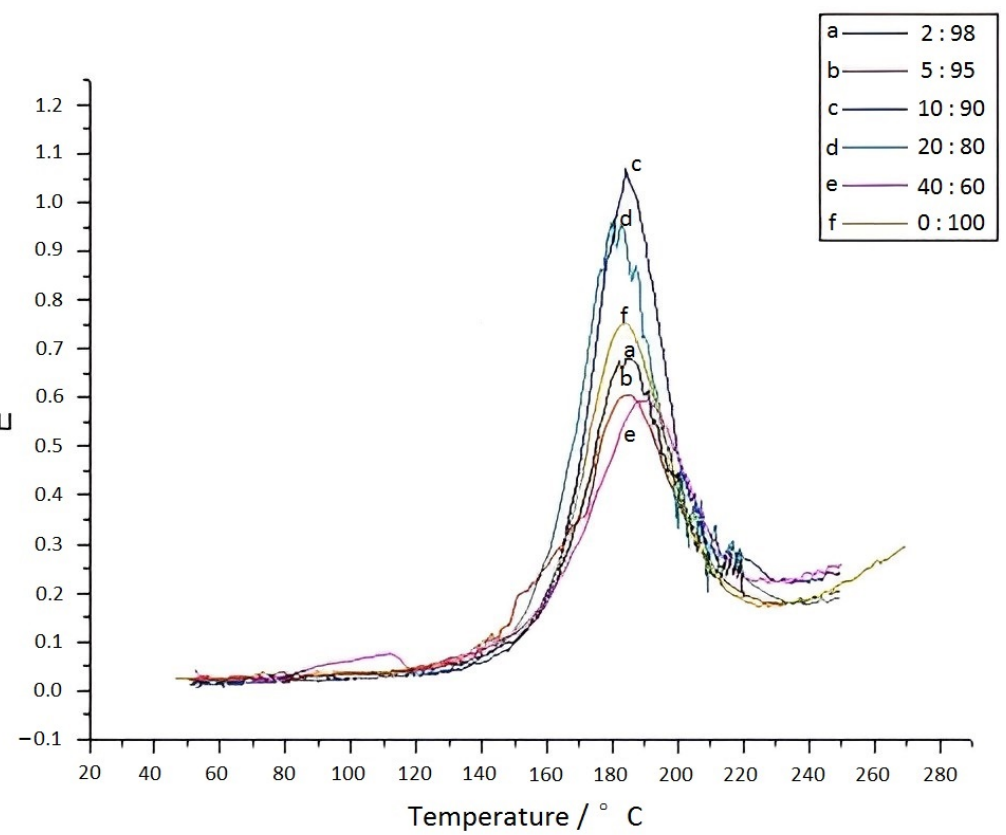
Figure 15. Plots of temperature versus loss factor for BZ composite material with different eugenol– furfuryl amine contents.